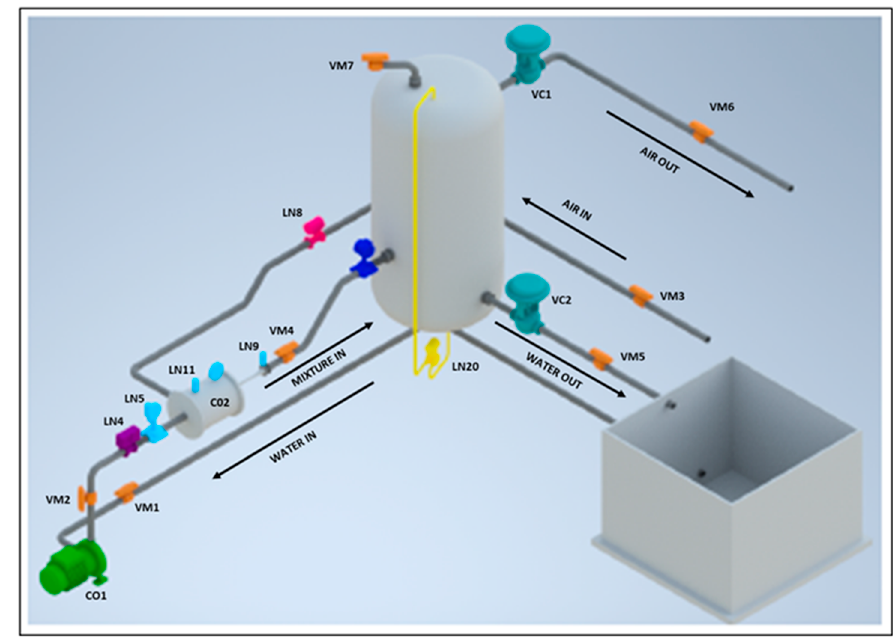
Figure 2. 3D scheme of the DIISM plant.